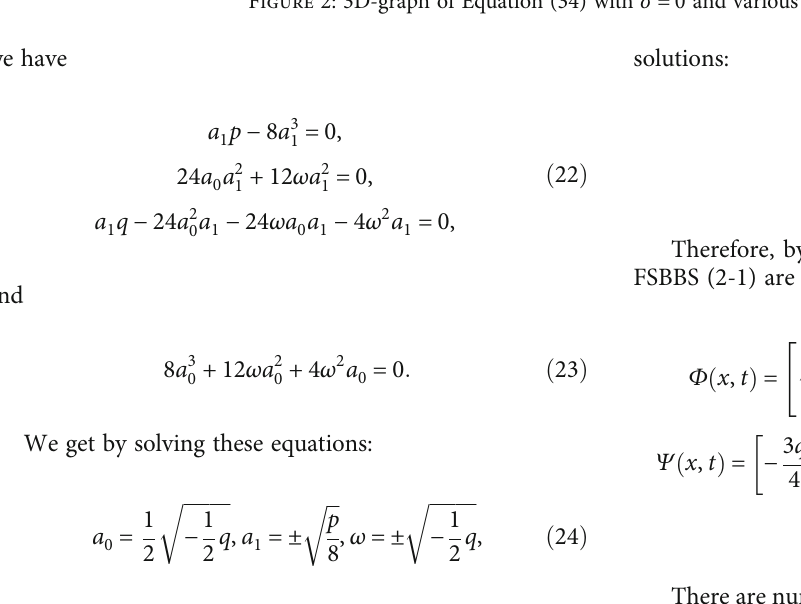
Figure 2: 3D-graph of Equation (34) with σ = 0 and various values of α = 1,0 : 5